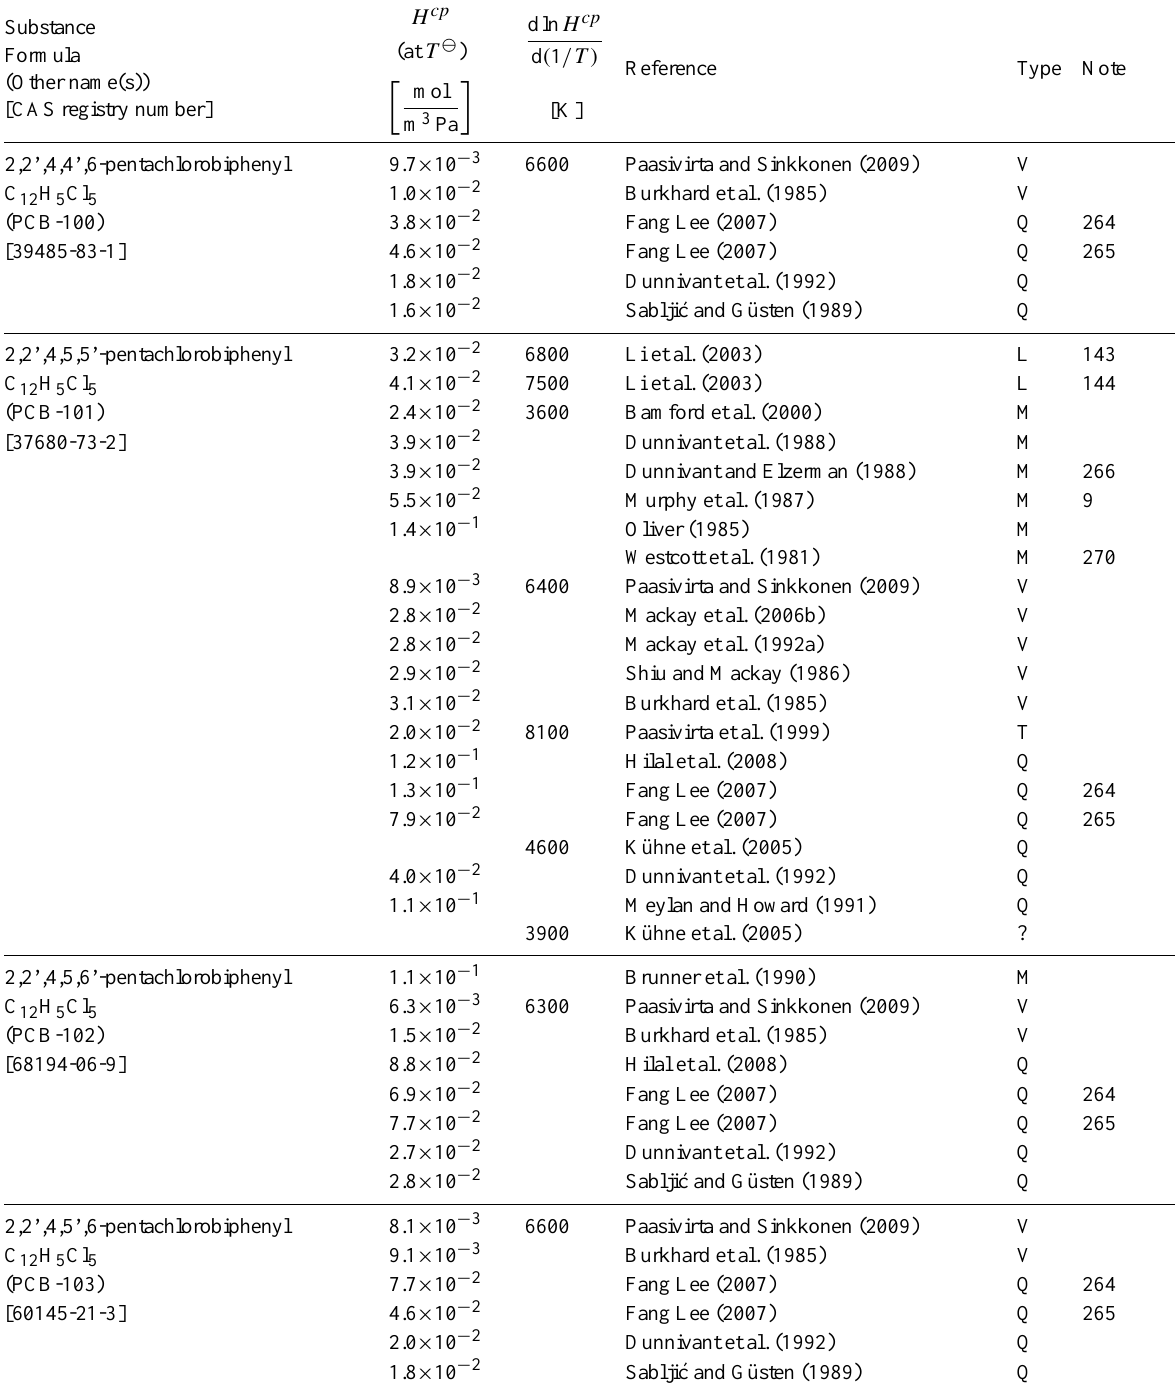
Table 6: Henry’s law constants for water as solvent